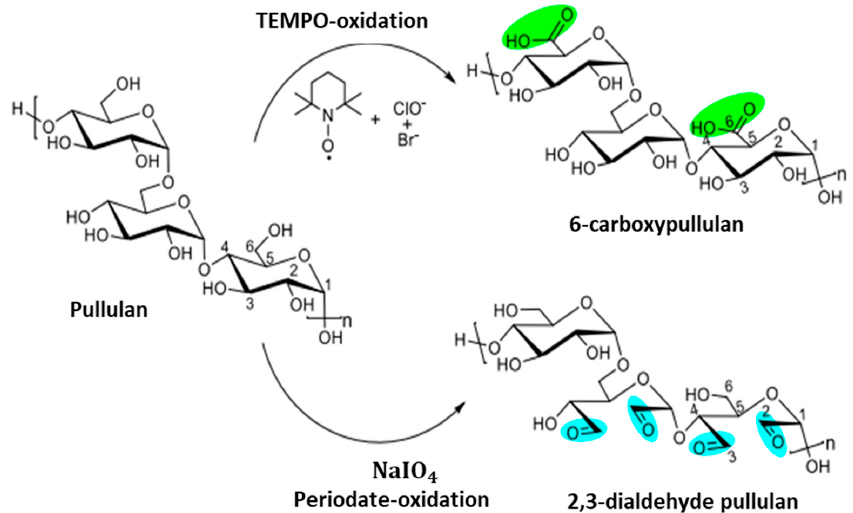
Figure 2. Illustration of pullulan oxidation using TEMPO and periodate. Reproduced from [53], with permission from Elsevier, 2022.